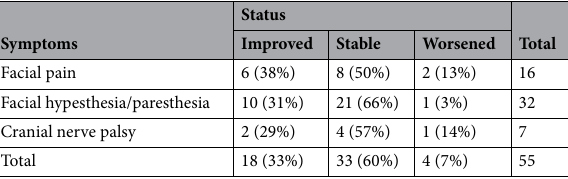
Table 3. Symptom outcome after gamma knife radiosurgery for trigeminal schwannomas.